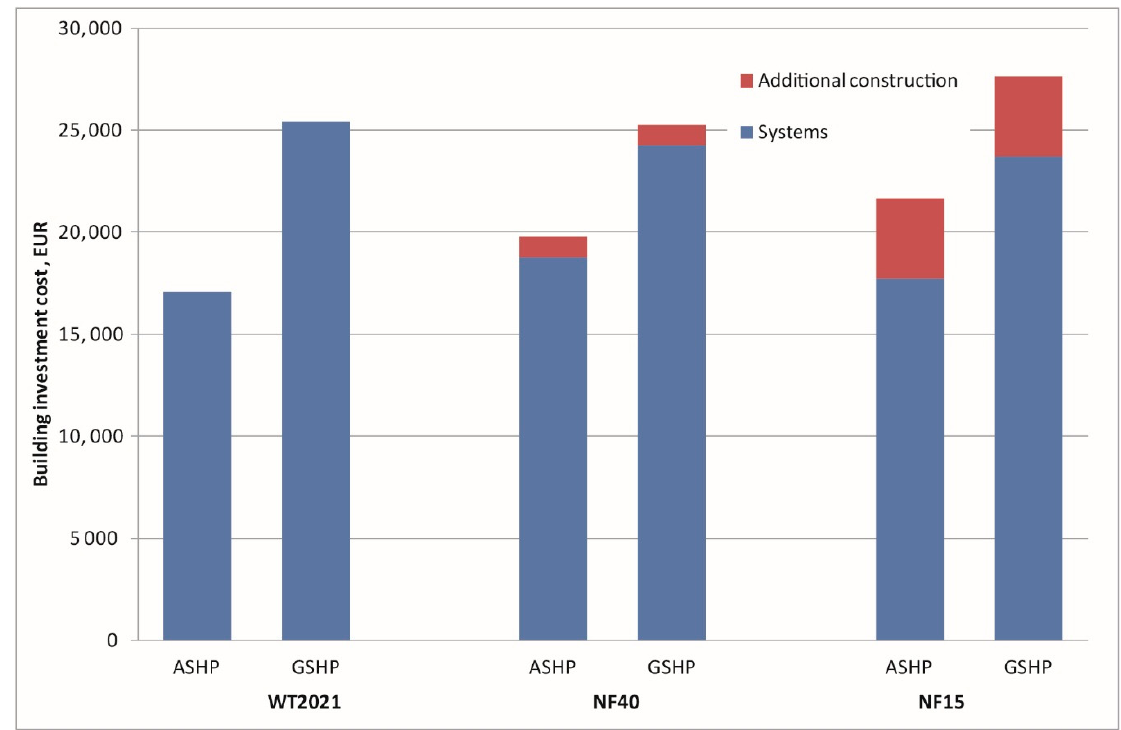
Figure 5. The investment cost for all the